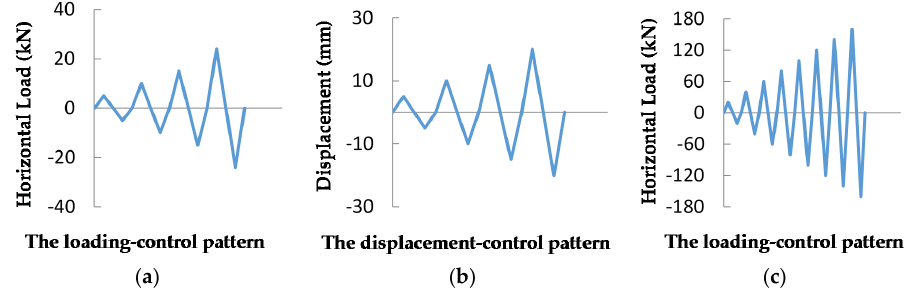
Figure 6. Equipment and measurement: ( a ) loading devices and indicator arrangement; ( b ) test scene; ( ① ‐ reaction wall; ② ‐ loading frame; ③ ‐ 50t jack; ④ ‐ 50t sensor; ⑤ ‐ loading beam; ⑥ ‐ displacement sensor for loading beam; ⑦ ‐ wall; ⑧ ‐ marble ‐ graphite isolator; ⑨ ‐ anchor block; ⑩ ‐ upper foundation beam; (cid:0) ‐ lower foundation beam; (cid:0) ‐ displacement sensor for upper foundation beam; (cid:0) ‐ dial indicator).